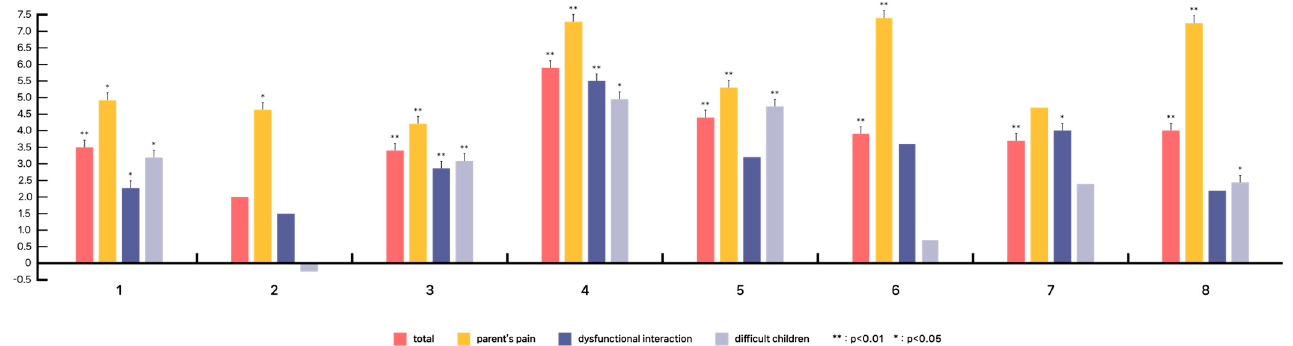
Figure 9. Effects of forest healing programs for caregivers in each institution. * The x-axis represents the areas of soopchewon and forest healing centers located throughout the country. The y-axis is the value of the K-PSI-SF changed after the program progressed. (1: Chuncheon, 2: Hoengseong, 3: Forest Healing Center, 4: Chilgok, 5: Cheongdo, 6: Naju, 7: Jangseong, 8: Daejeon).